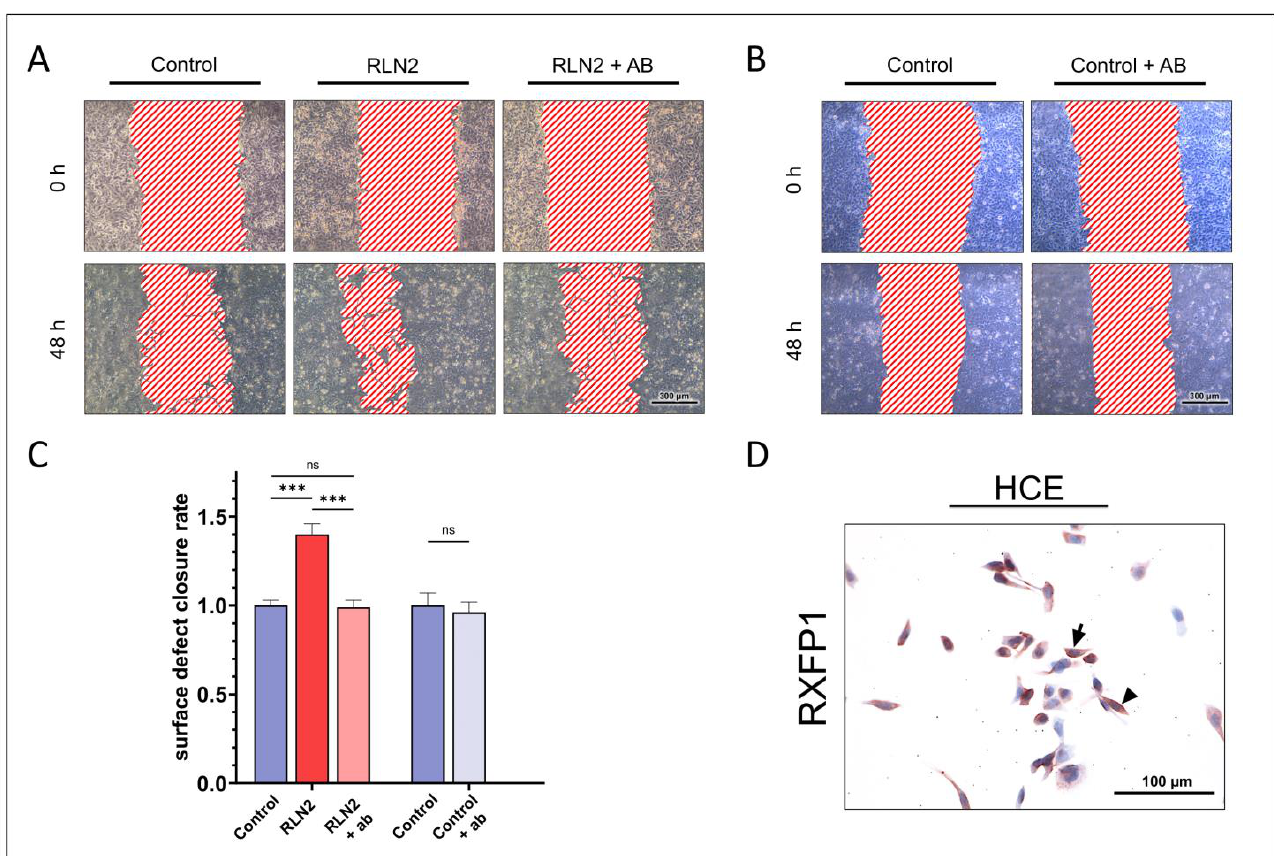
defect closure rate. Bars represent mean ± SEM. Analog to HCE, scratch assays were performed on HCjE cell line. Neither stimulation with 10 ng/mL nor 100 ng/mL CTRP1, CTRP6 or CTRP8 did increase the relative surface defect closure rate significantly when compared to the control (one-way ANOVA; p > 0.05).